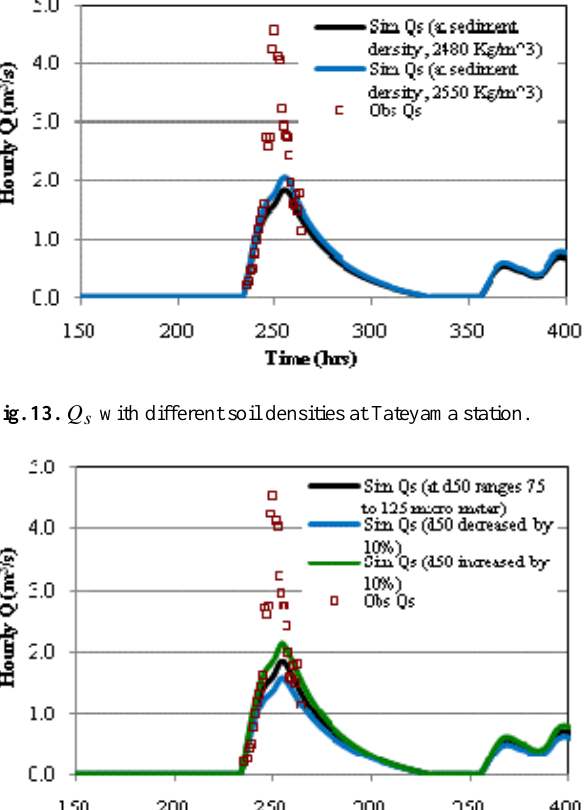
Fig. 14. Q s with different d50 values at Tateyama Fig. 14. Qs with different d values at Tateyama station. 50